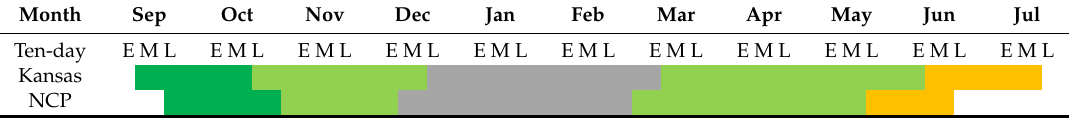
1 Green color represents sowing, light green represents the development of winter wheat, gray represents over-winter, and orange represents harvesting. E, M, and L represent the early 10 days, the middle 10 days, and the last 10 days of a month,